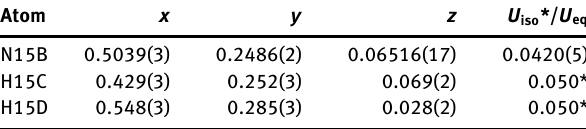
Table 2: Fractional atomic coordinates and isotropic or equivalent isotropic displacement parameters (Å 2